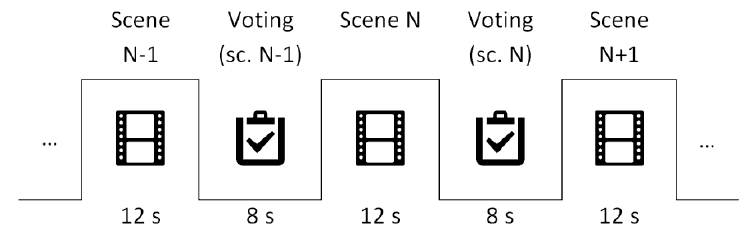
Figure 3. Scene-voting sequence time pattern.